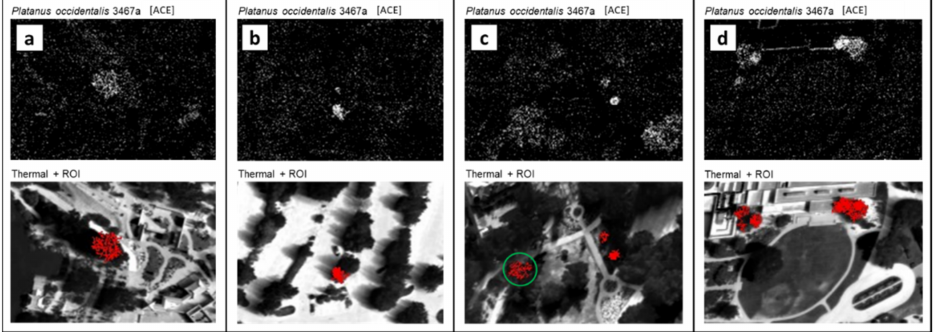
Figure 18. Platanus spp. specimens ID’d with the P. occidentalis spectrum: ( a ) P. wrightii (Huntington Gardens), ( b ) P. orientalis (Huntington Gardens), ( c ) P. x acerifolia (circled) and two P. mexicana (Lacy Park), ( d ) groups of three (left) and two (right) P. racemosa (Huntington